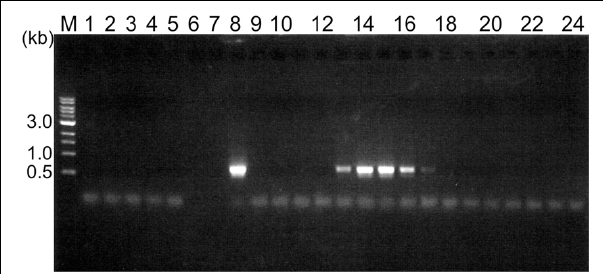
FIGURE 1 | Amplification of a region within the family A DNA polymerase gene from the environmental DNA. PCR reaction mixtures were fractionated by 1% agarose gel electrophoresis, and the DNA bands were visualized by ethidium bromide staining. The lane numbers represent the serial numbers of the samples obtained from the hot spring areas in the Tohoku and Kyushu districts.